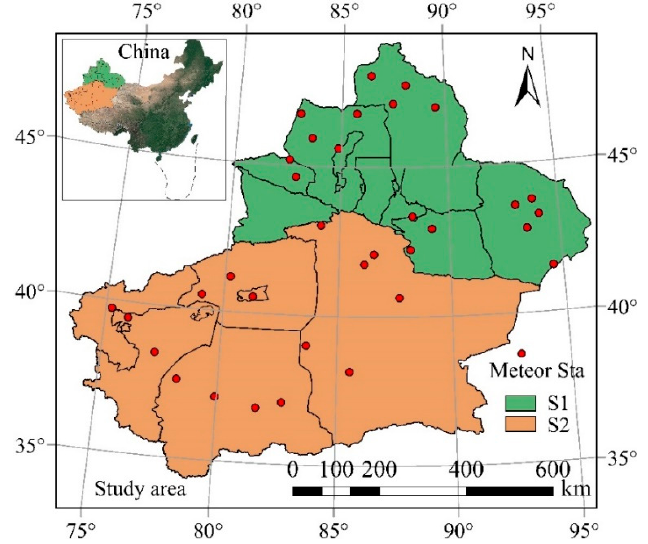
Figure 1. Distribution of meteorological stations in the studied region.